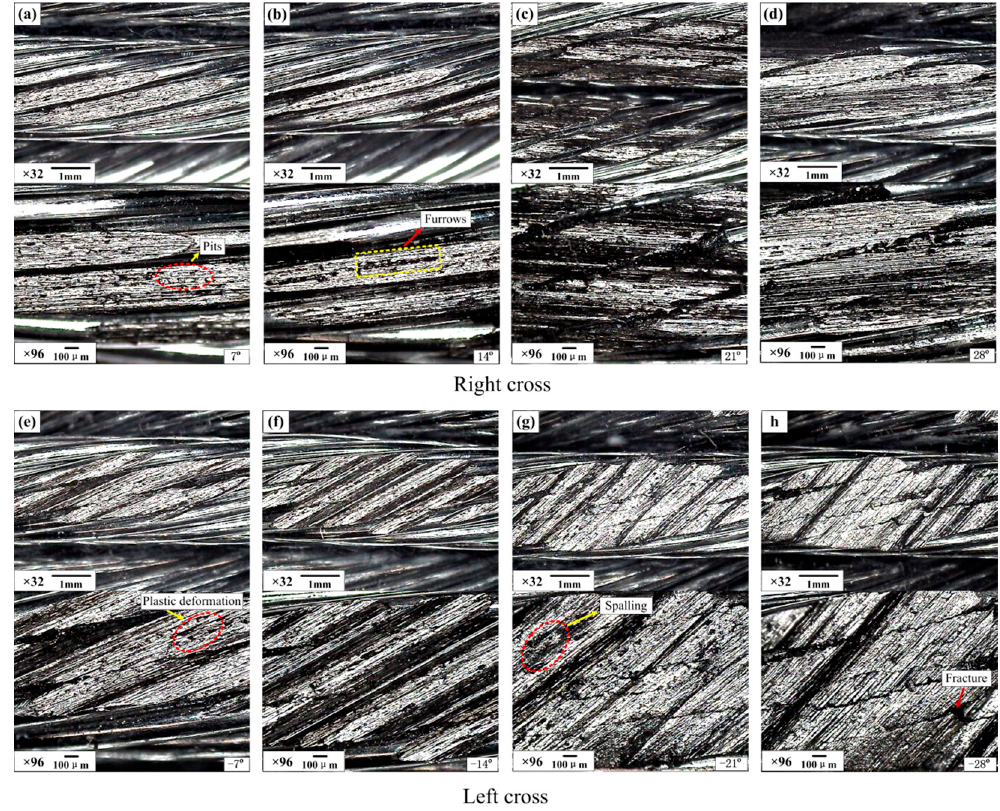
Figure 14. Industrial microscope images of the wear surface of the upper loading rope for different conditions ( x : 10 mm; v : 6 mm/s). ( a – d ): Right cross contact; ( e – h ): left cross contact.